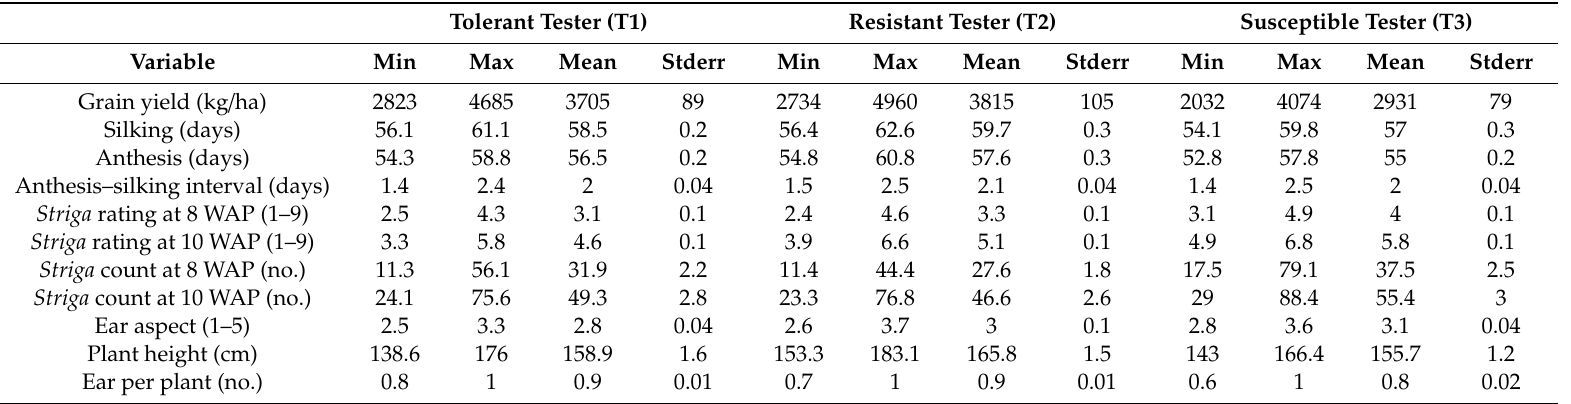
Table 4. Means, maximum, minimum and standard error (Stderr) of agronomic traits for the testcrosses of yellow maize from three testers under the Striga -infested condition across four environments.